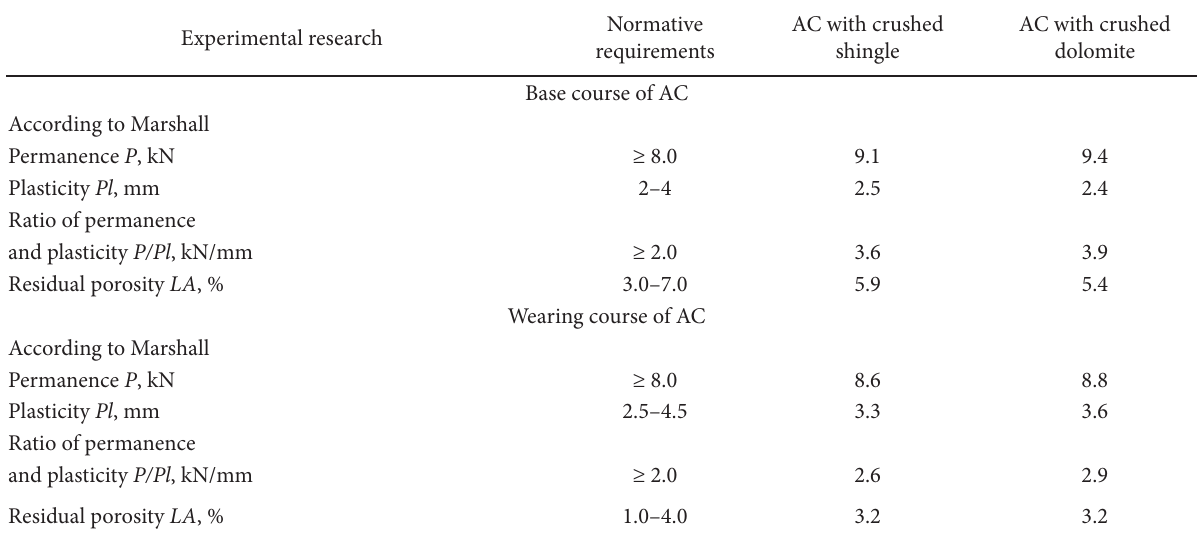
Table 3. Summary of the results of experimental research in AC mixtures Experimental